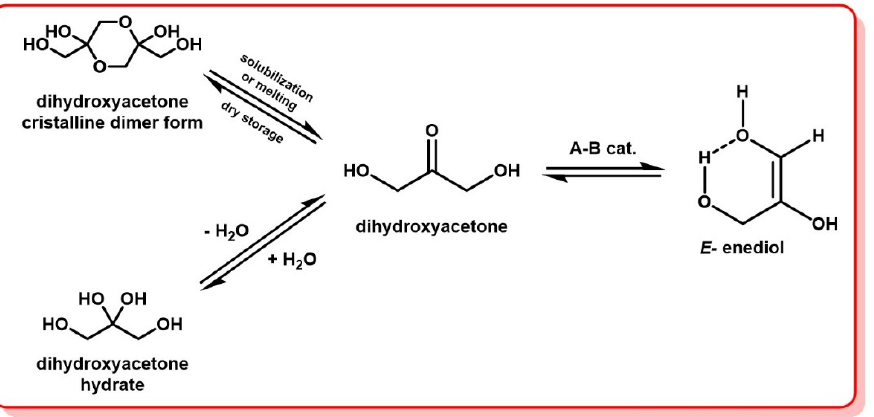
Figure 10. Common forms of DHA and interconversion to enediol intermediate in aqueous